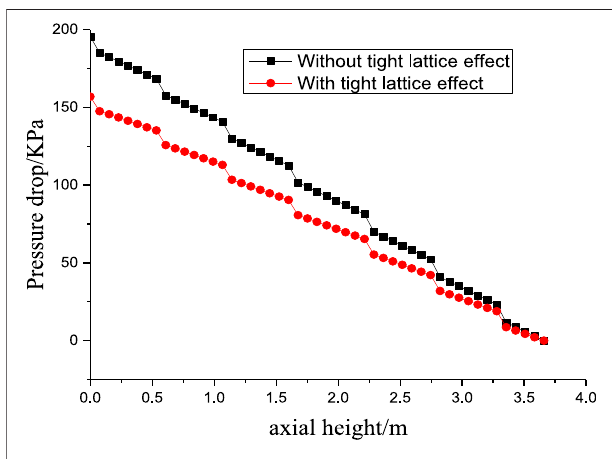
FIGURE 7 | Pressure drop of 5 × 5 annular fuel assembly.